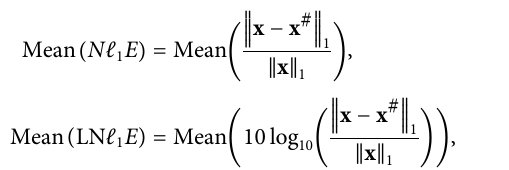
ℓ 1 -estimation error and the mean of the logarithmic relative ℓ 1 -estimation error, i.e.,